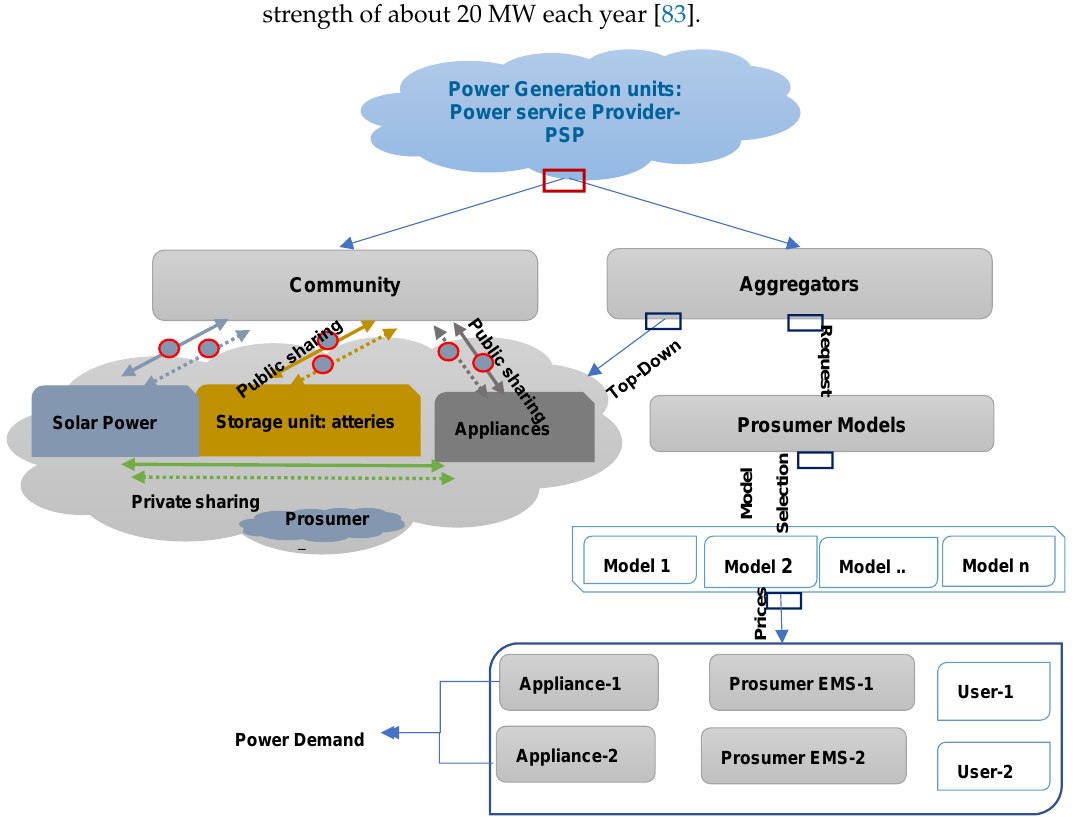
Figure 5. Prosumer Energy Management